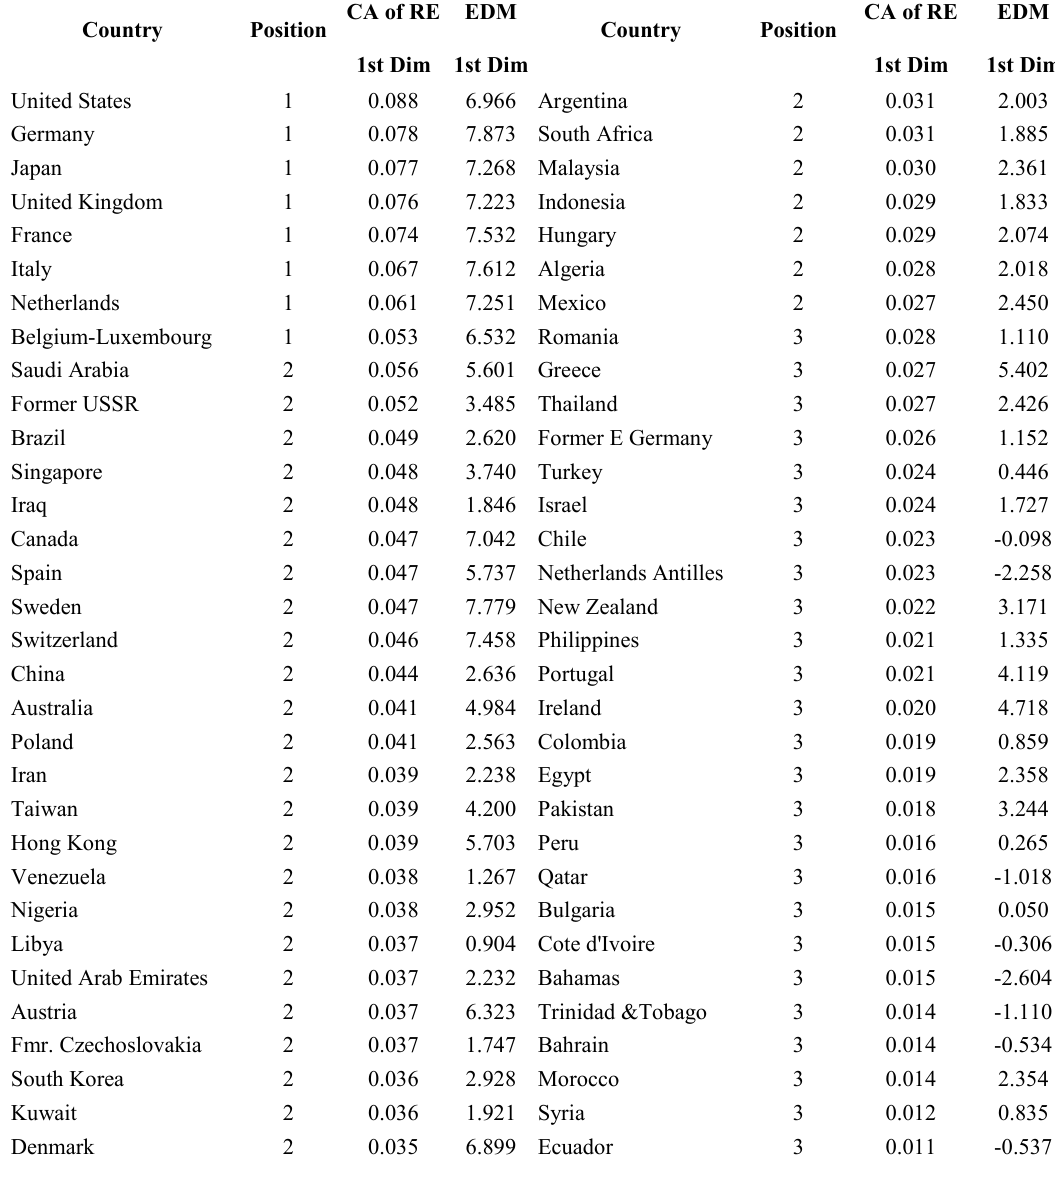
Table A1a: Core and Semi-Periphery in 1980, ranked by position and CA of